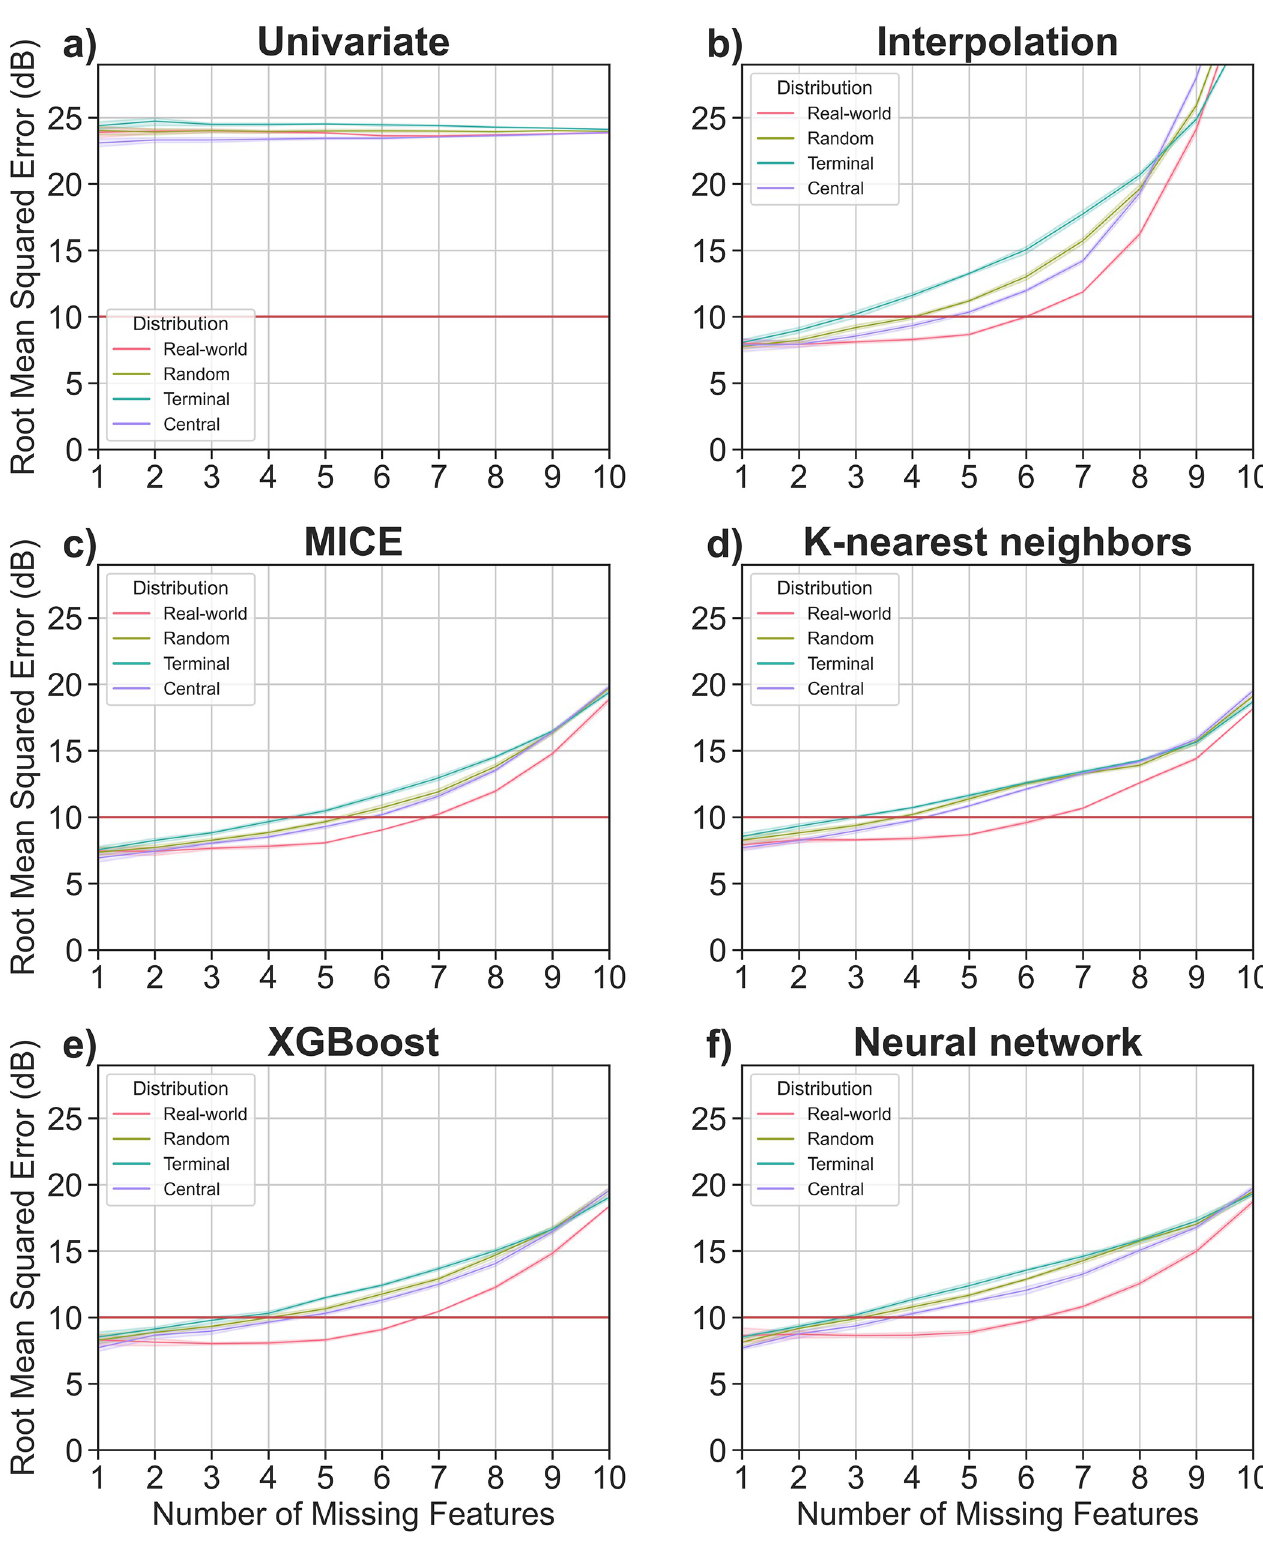
Fig 5. Quantity and distribution of sparsity. Assessment of model performance on sparse datasets with different degrees of sparsity (1–10 of 11 features) and sparsity distributions (Real-world, Random, Terminal, Central). Colored lines denote mean root mean squared error; shaded bands represent 99% confidence